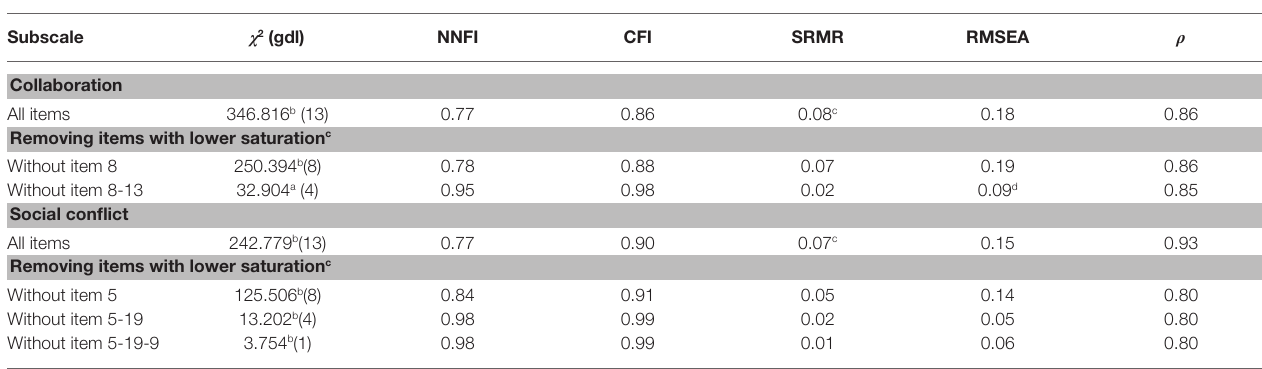
TABLE 2 | Fit indices – “collaboration” and “social conflict” subscale.